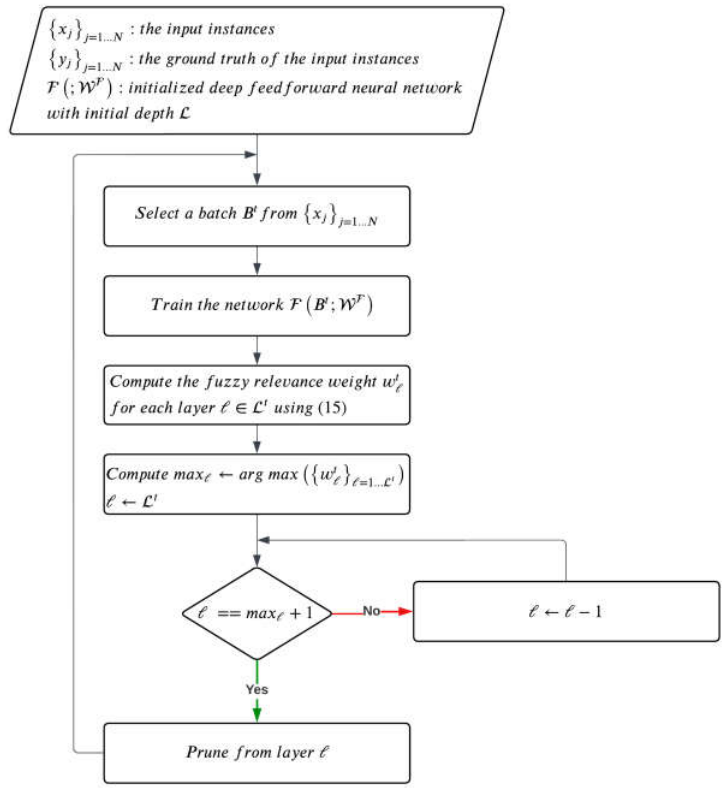
Figure 2. Flowchart of the proposed approach.